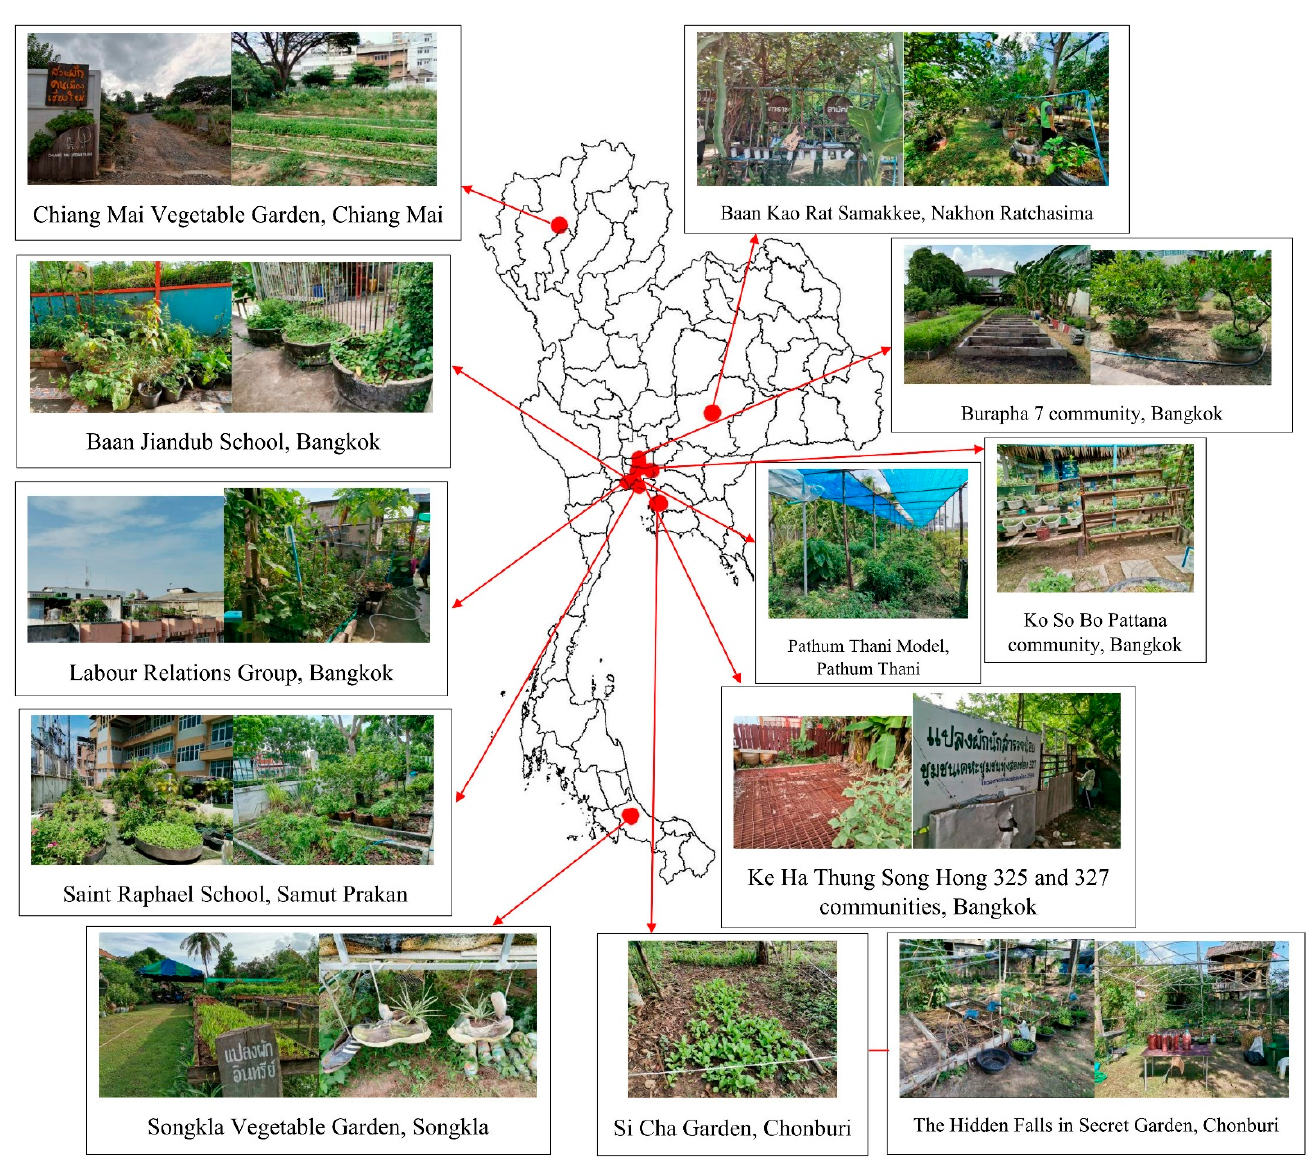
Figure 2. Study areas.